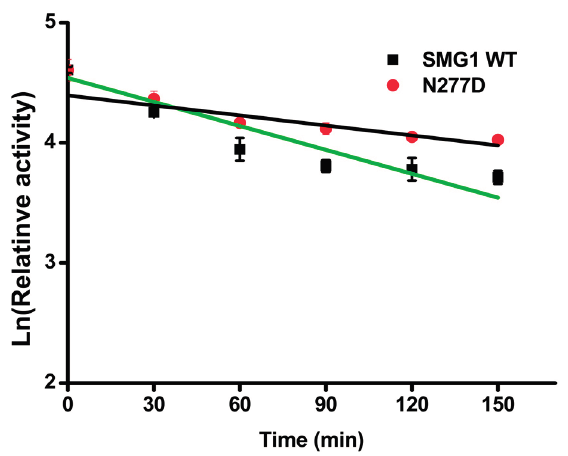
Figure 2. Deactivation of SMG1 WT and N277D. Enzymes were incubated at 45 °C and residual activity was measured every 30 min. The data were fitted to the first-order plots. The half-life of SMG1 (green line) and N227 (black line) were calculated as 121 and 187 min respectively based on the formula of T 1/2 = ln 2/ k d